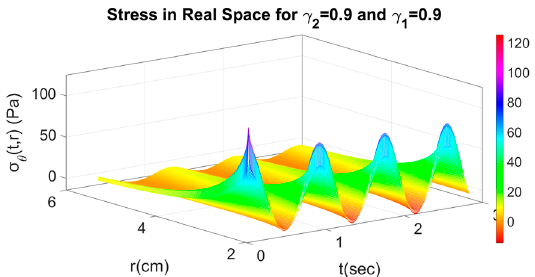
Figure 13. Distribution of the stress σ θ ( t , r ) in the initial space with space (porosity) fractional order γ 1 = 0.9 and time fractional order γ 2 = 0.9.